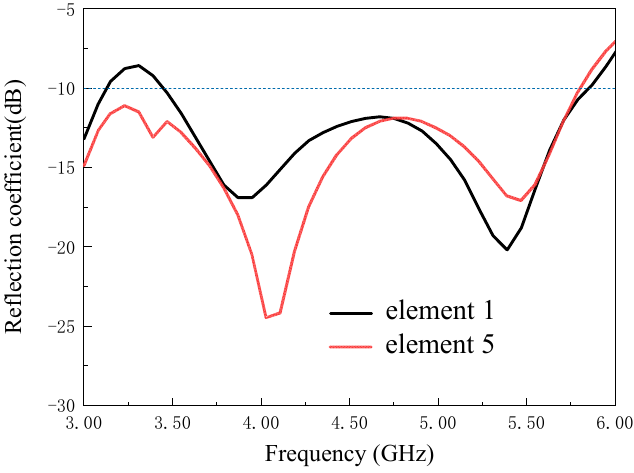
Figure 9. Vivaldi linear array model. Numbers 1–8 are the serial numbers of antenna units. Figure 10 is the S parameters of the Vivaldi linear array, and the reflection coefficients of the fifth element in the middle and the first element at the edge are also given.